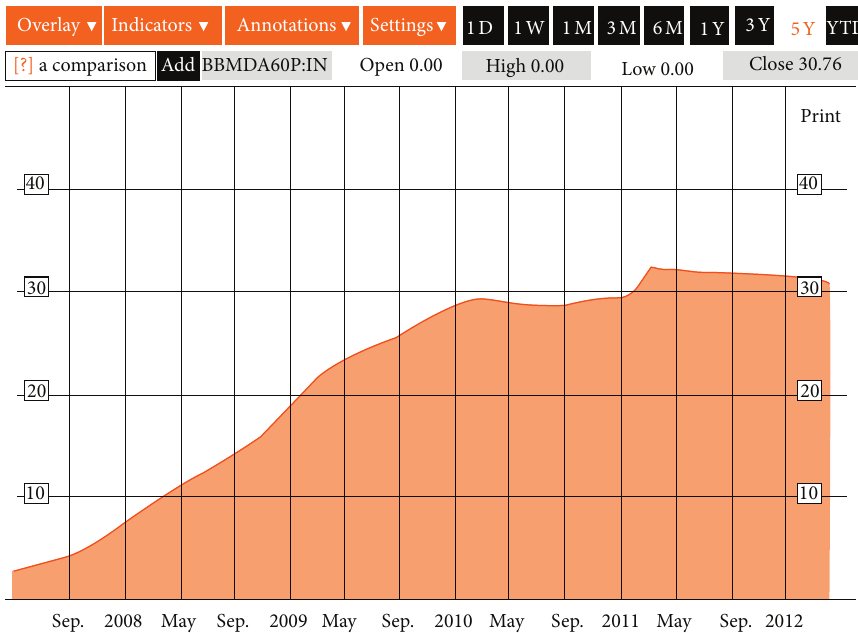
Figure 7: Bloomberg (60+ days) delinquency rate for Alt-A mortgage segment (May 2007–March 2012). Source: Bloomberg Finance L.P. used with permission of Bloomberg L.P. Copyright 2012. All rights